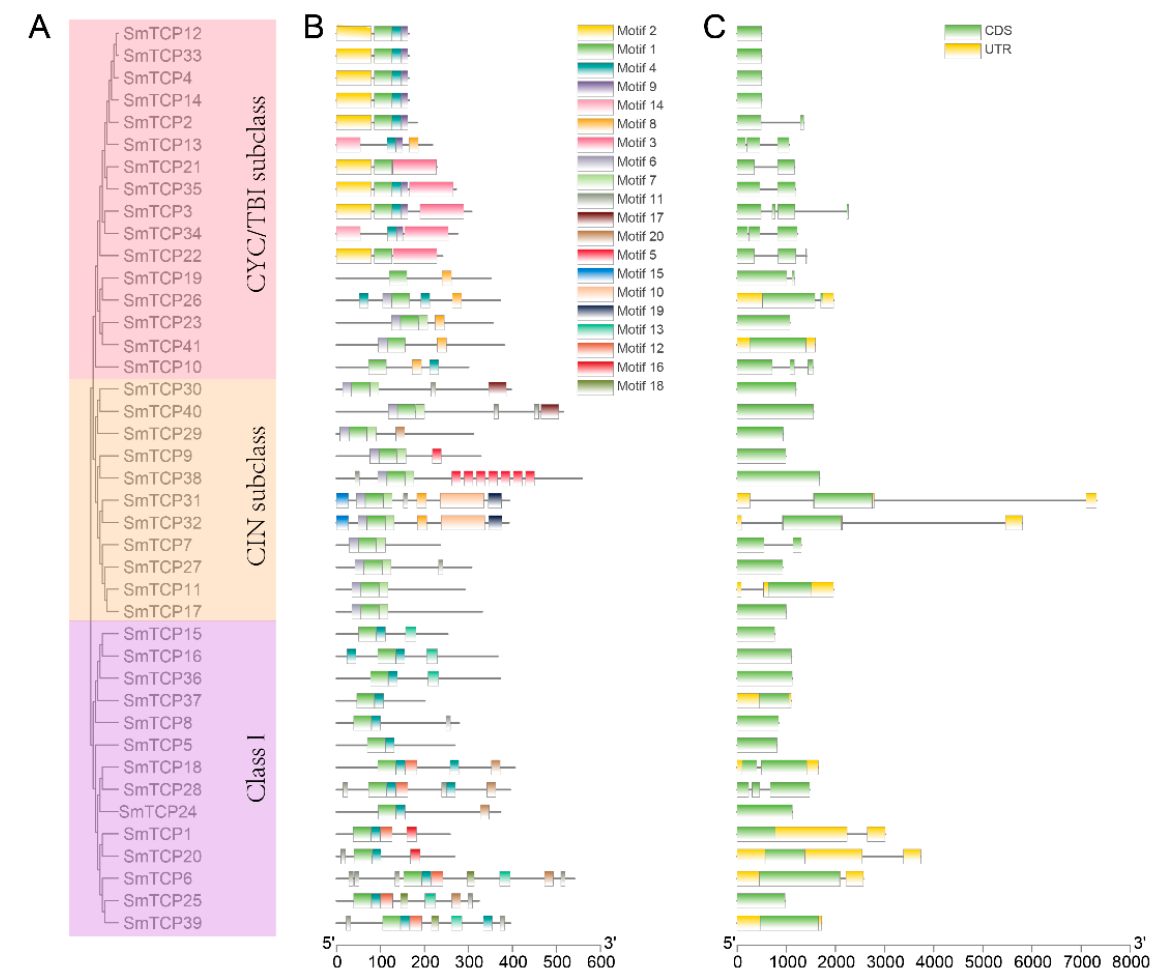
Figure 3. Phylogenetic tree, conserved motifs, and gene structure analyses of SmTCPs. ( A ): Phyloge- netic tree. ( B ): Conserved motif. The colored boxes on the right denote motifs 1–20. ( C ): Gene structure. The yellow boxes, black lines, and green boxes represent UTR, introns, and CDS, respec- tively.